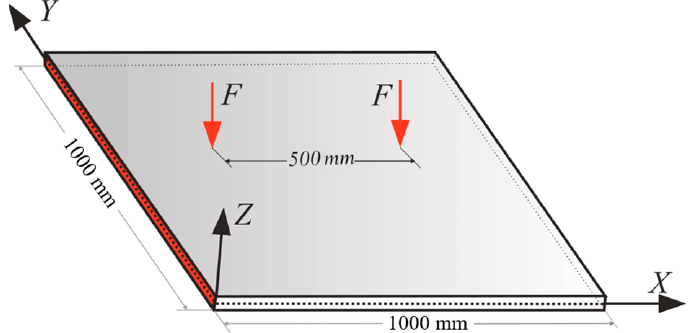
Figure 15. The partially clamped plate under two concentrated forces.